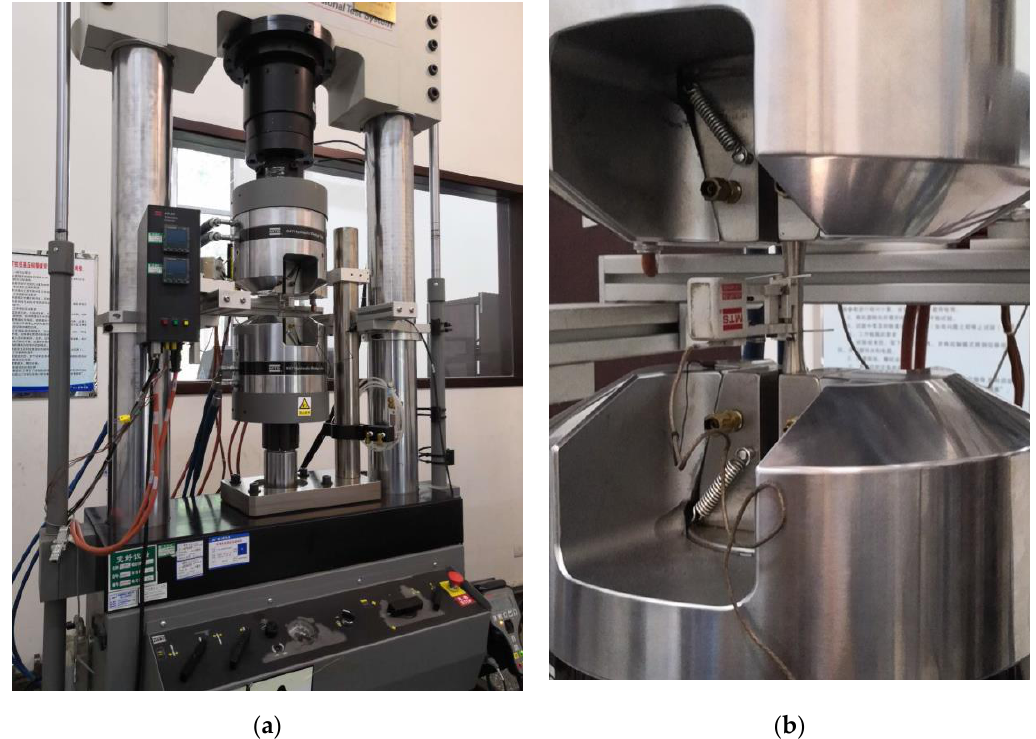
Figure 2. ( a ) Electro-hydraulic servo universal testing machine MTS-370-250KN; ( b ) specimen in the machine.